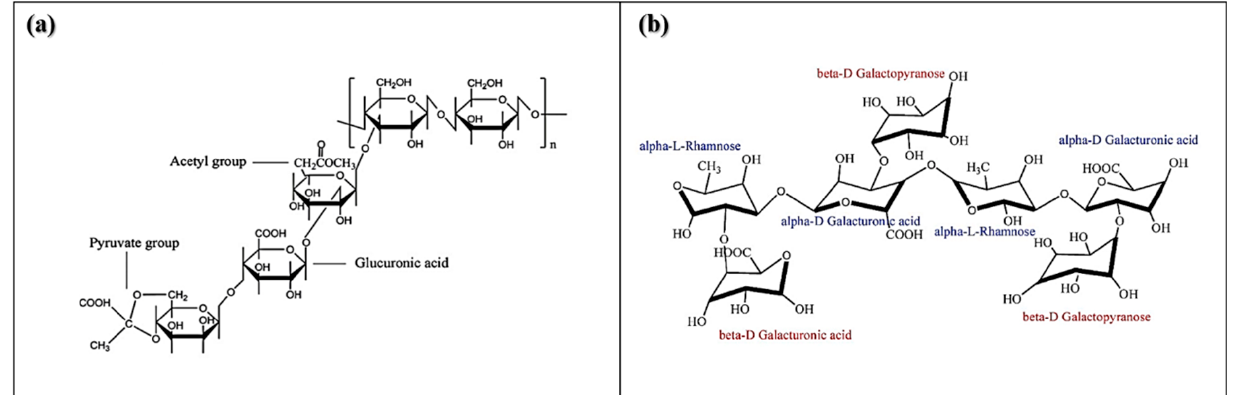
Figure 1. Chemical structures of ( a ) xanthan gum and ( b ) karaya gum